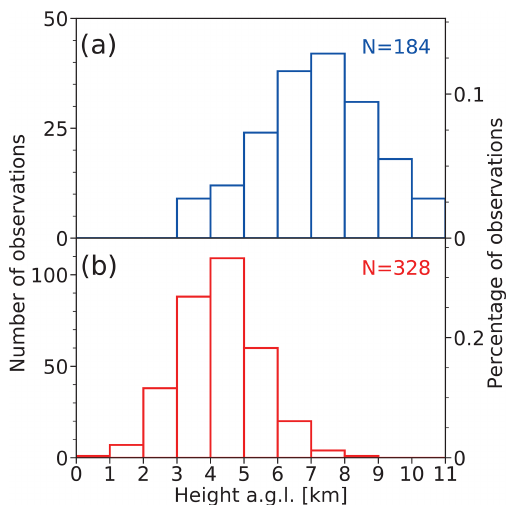
Figure 4. Histograms of layer top heights for (a) the uppermost layer (blue) and (b) the main aerosol layer (red). Total number of observations is